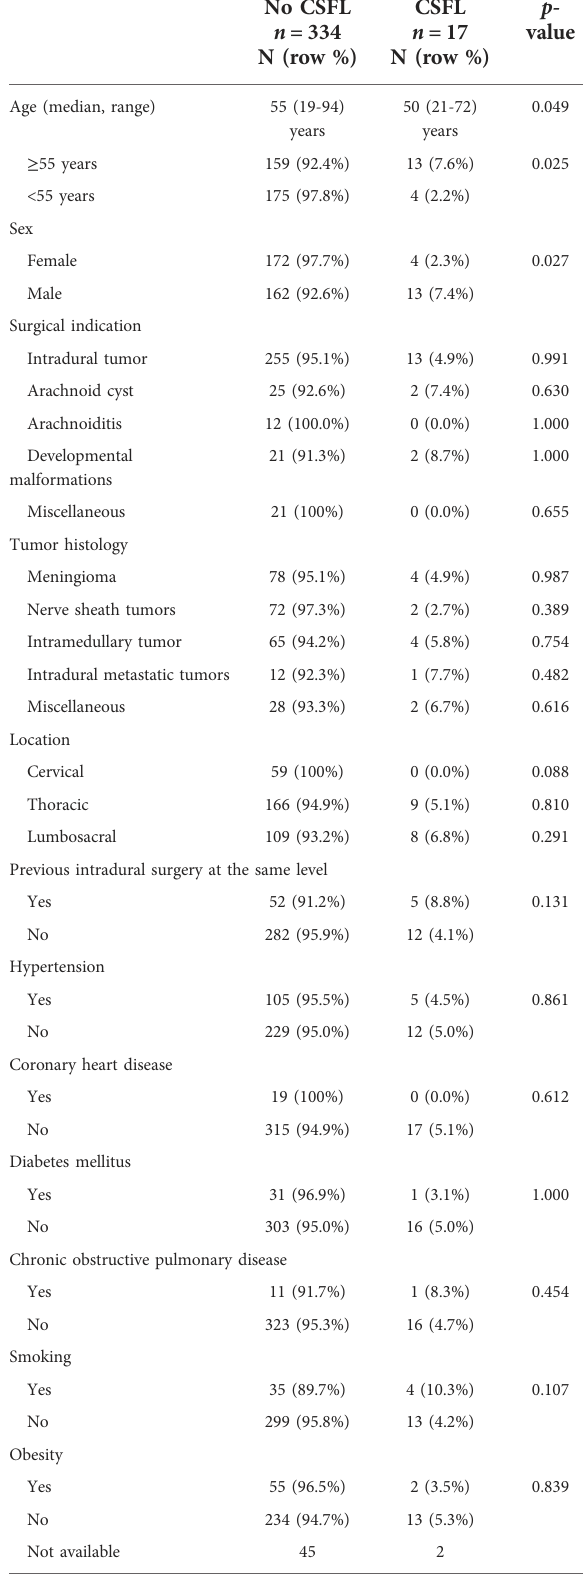
TABLE 1 Patient and case-related